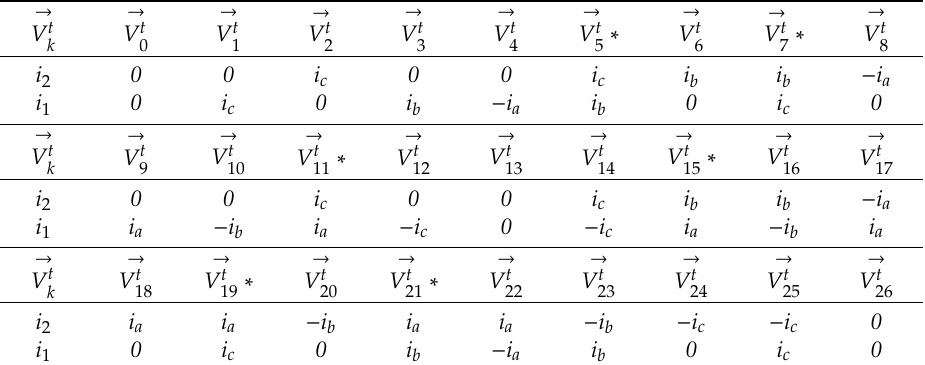
Table 2. Parameters of simulation and laboratory models of the 2 kVA 12-pulse rectifier.